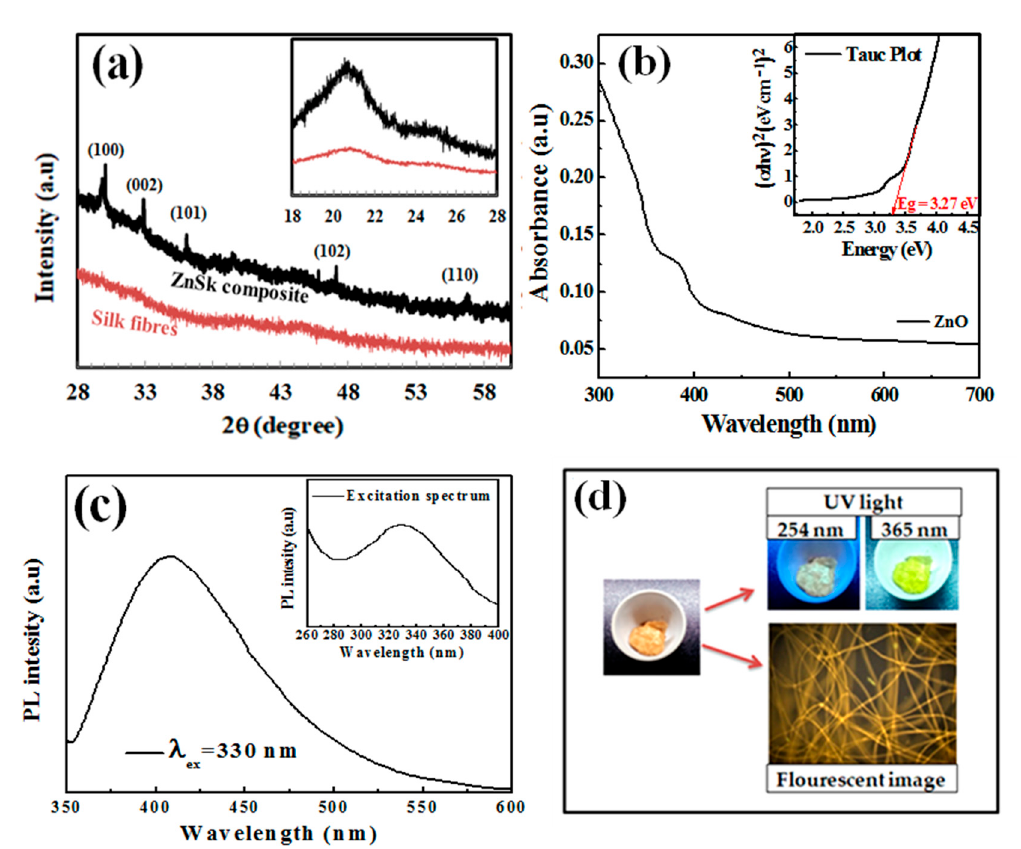
Figure 3. ( a ) X-ray diffraction (XRD) patterns of silk fibers and ZnSk composites. The hexagonal crystal system of ZnO with facets are indicated above the diffraction pattern of ZnSk composites, ( b ) UV-visible spectrum of ZnSk and Tauc plot depiction (inset), ( c ) fluorescence spectra of ZnSk and its excitation spectrum (inset), ( d ) visible emissions from ZnSk composites in a UV box and fluorescence microscopic observation with blue excitation.